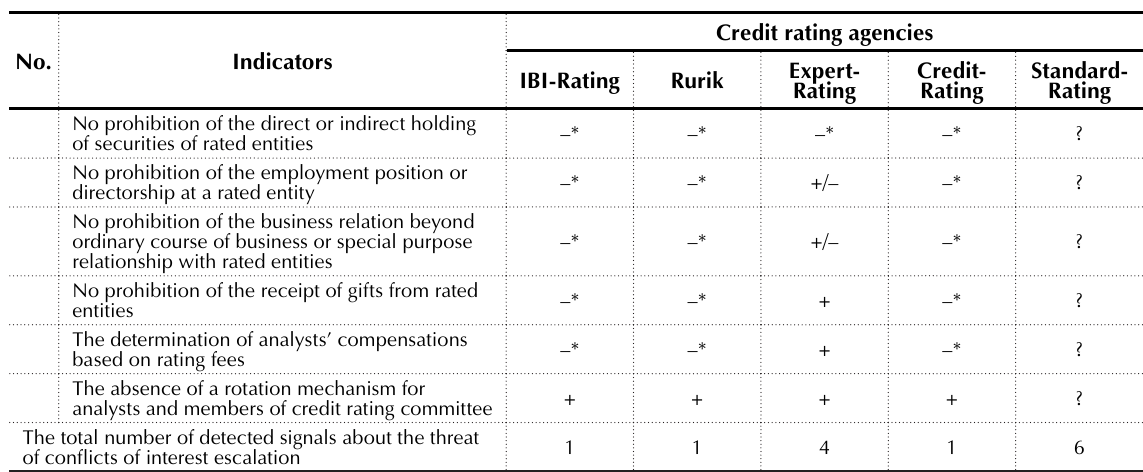
Table 5. The warning signals concerning the potential of conflicts of interest in models ensuring the independence of employees of CRAs in